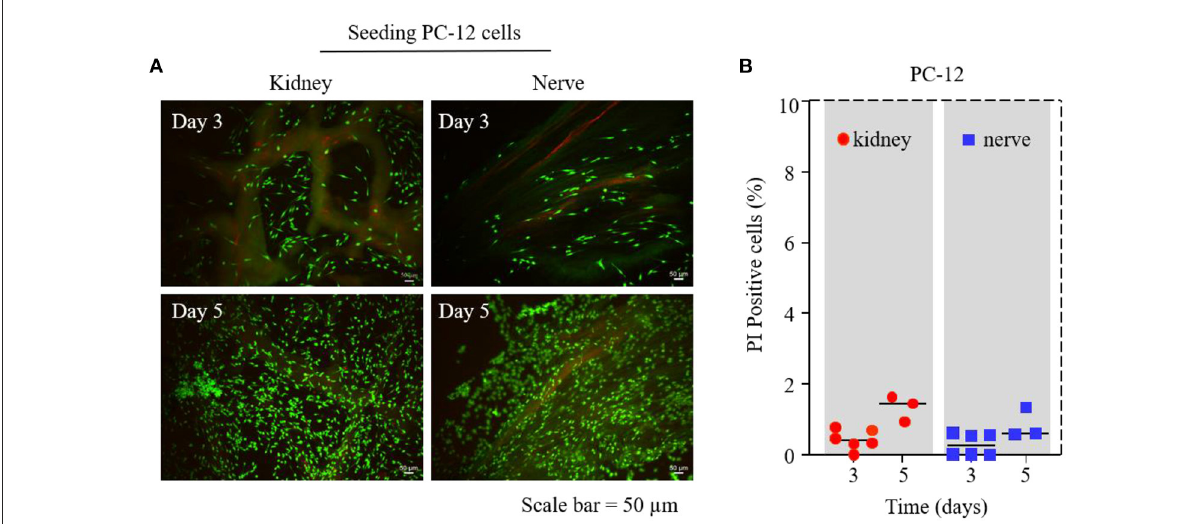
FIGURE3 PC-12 cell survival test on dK and dN; (A) Live/Dead assay by Calcein-AM and PI staining on days 3 and 5—living cells are depicted in green and dead cells are in red; (B) statistical cell-viability quantification of PI-positive cells (dead cells).